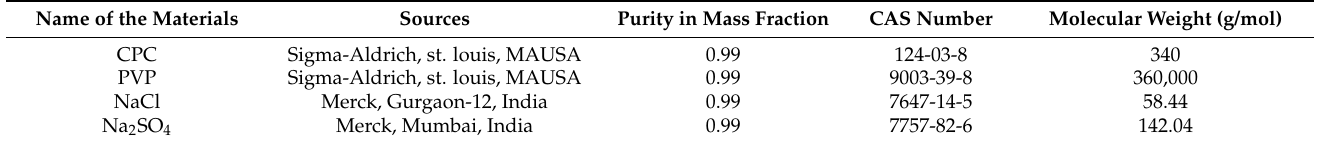
Table 1. Information of used materials.